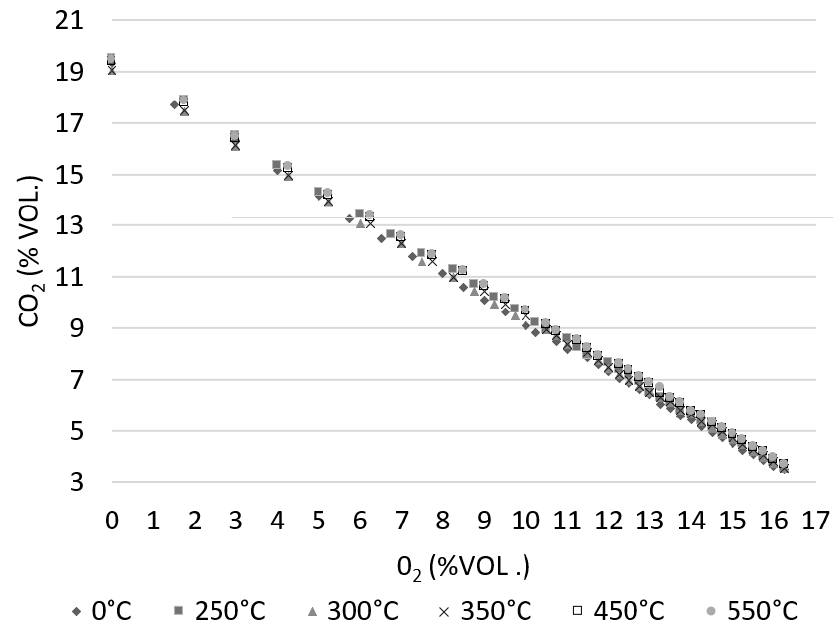
Figure 7. Mutual influence of oxide and carbon dioxide.